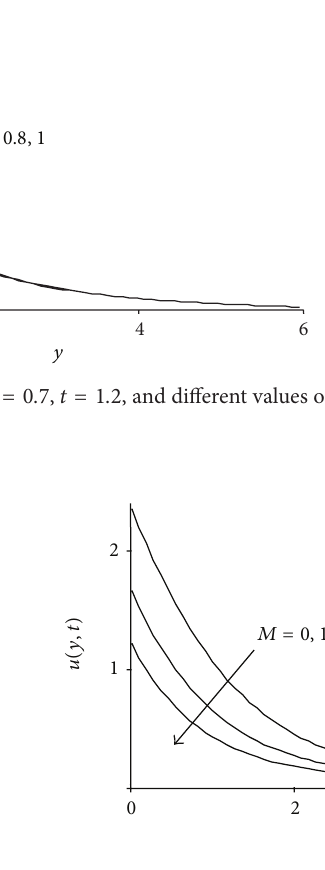
Figure 5: Velocity profiles for Pr eff = 0 . 350 ( 𝑁 𝑟 = 1, Pr = 0 . 7), = 0 . 7, 𝑡 = 1 . 2, and different values of 𝑀 when the plate applies 𝐾 𝑝 constant shear stress 𝑓 = − 0 .